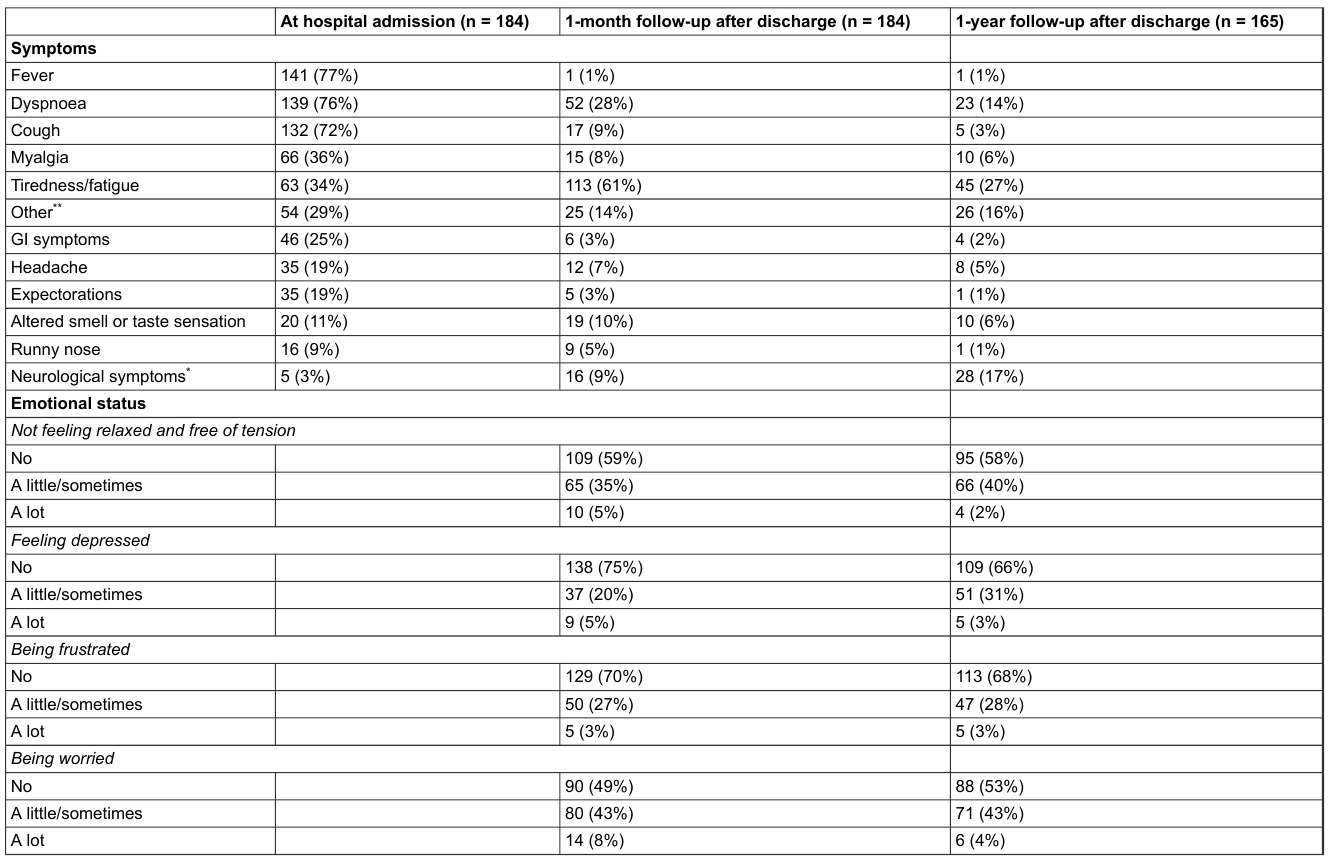
Table 2: Symptoms and emotional status in discharged COVID-19 patients.